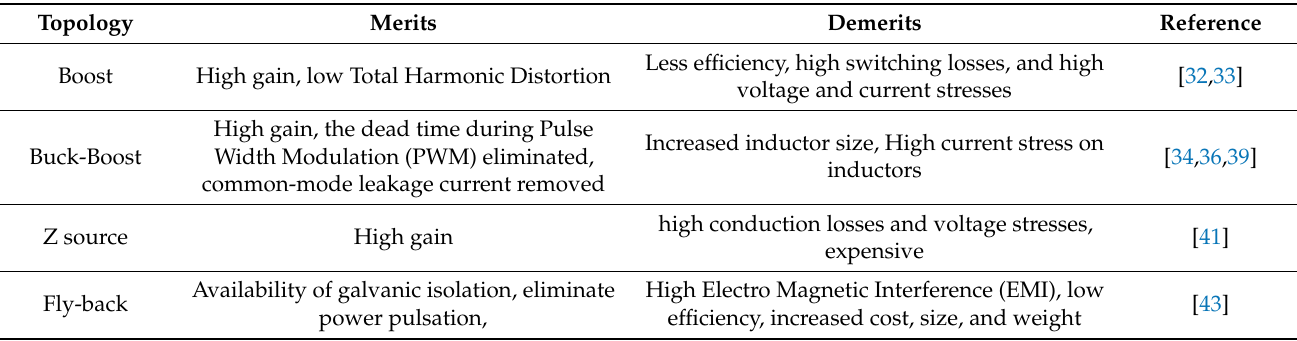
Table 4. Merits and demerits of the various single stage